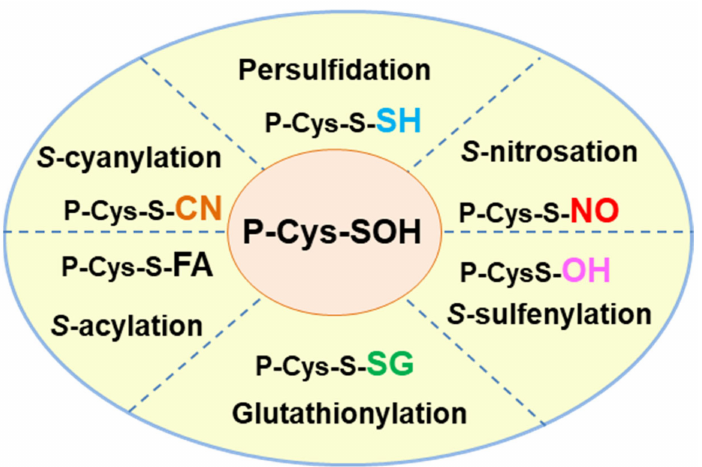
Figure 3. Hallmark of the different oxidative posttranslational modifications (oxiPTMs) of cysteine- containing proteins including persulfidation, S -nitrosation, S -sulfenylation, glutathionylation, S - acylation and S -cyanylation which are mediated by hydrogen sulfide (H 2 S), nitric oxide (NO), hydrogen peroxide (H 2 O 2 ), glutathione (GSH), fatty acid (FA) and cyanide (CN - ), respectively. The thiol group (-SH) of Cys residues works as a redox switch and each of the PTMs can modify the function of the target protein either positively or